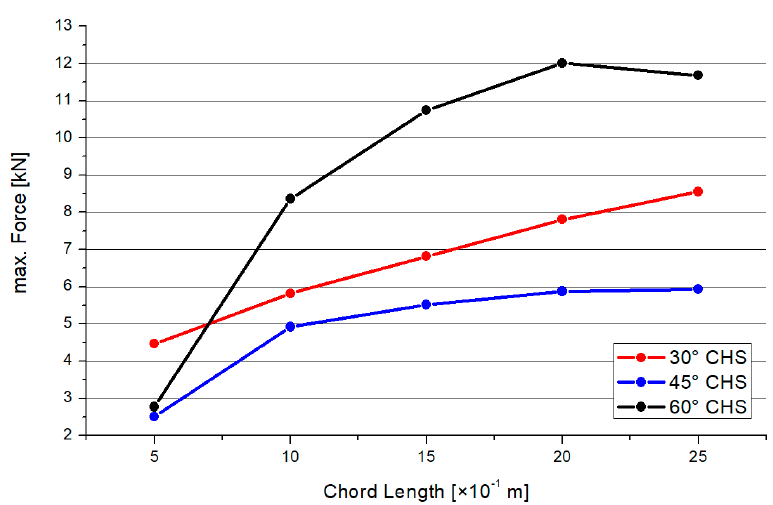
Figure 18. Results—Maximum Compression Force.